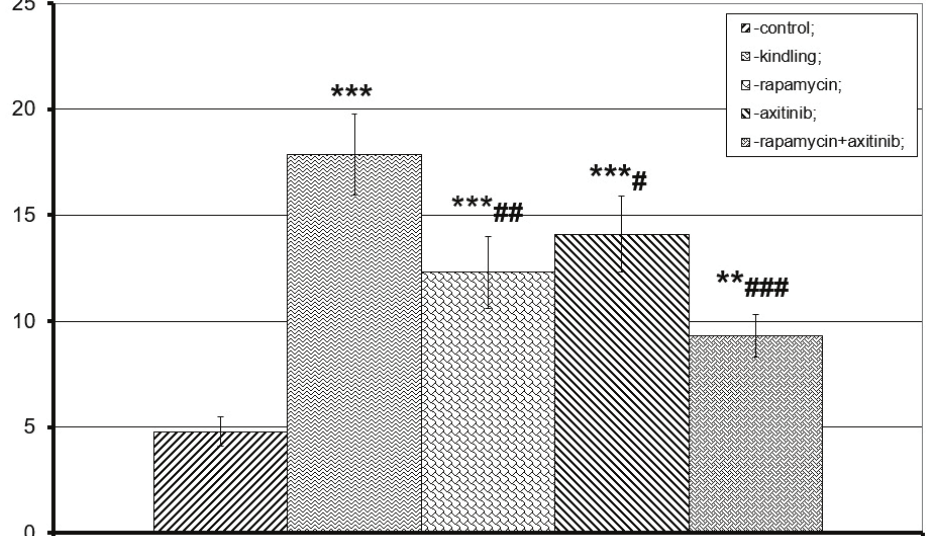
Fig. 6. Effects of treatment with rapamycin and axitinib upon TNF-α expression in the hippocampus of kindled